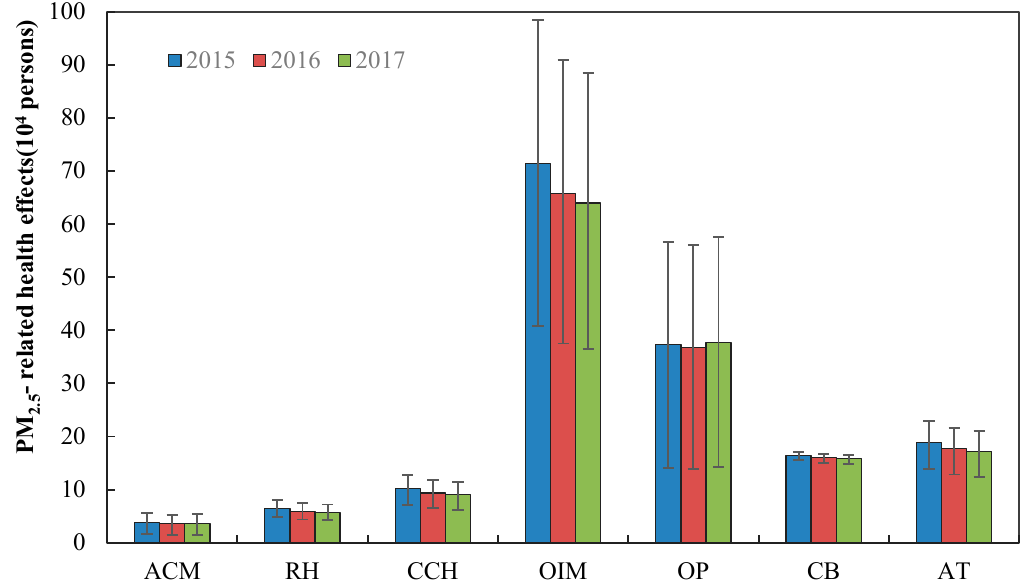
Figure 3. Health effects related to PM 2.5 in Gansu Province from 2015 to 2017. Note: In Figure 3, ACM, RH, CCH, OIM, OP, CB, AT refer to all-cause mortality, respiratory hospitalization, cardiovascular